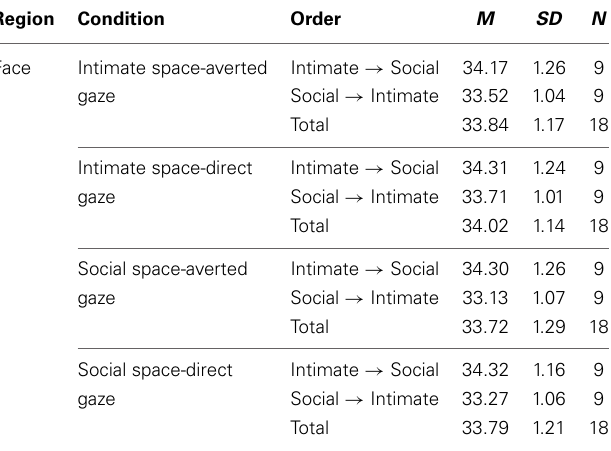
Table 2 | Mean Temperature values for the face according to